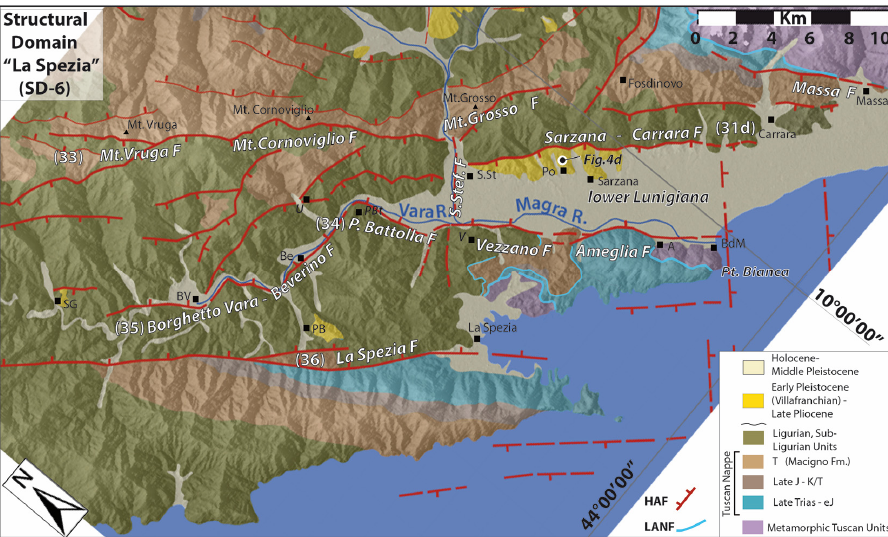
Figure 10. Main fault systems and geology in the structural domain SD6 (La Spezia–lower Lunigiana). The map is derived from [58,107] and our work. Fault identification numbers are as reported in Table S1. HAF: steep normal faults; LANF: low-angle detachment faults; A: Ameglia; BdM: Bocca di Magra; Be: Beverino; BV: Borghetto Vara; PB: Pian di Barca; PBt: Piano Battolla; Po: Ponzano